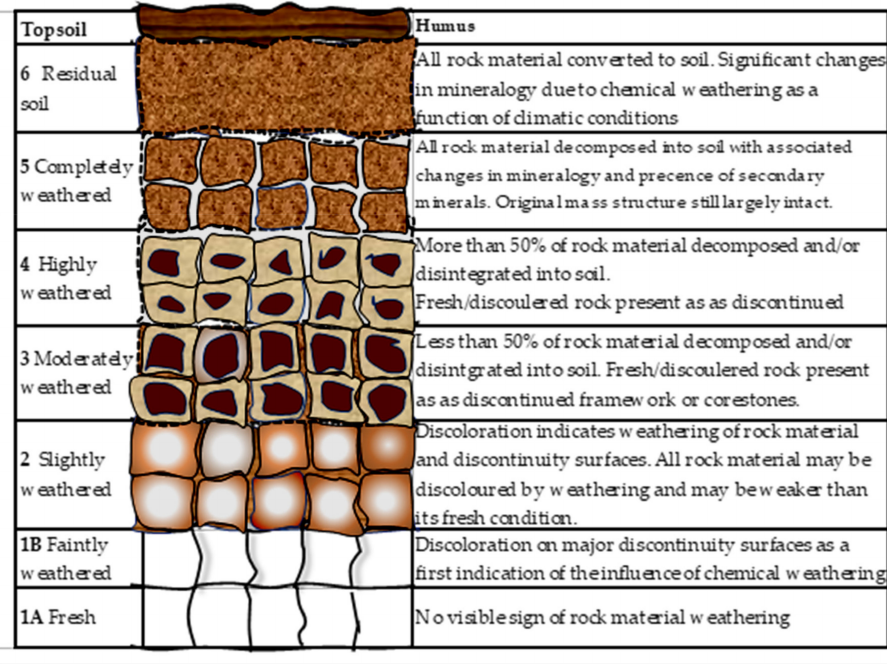
Figure 8. Schematic illustration of tropical weathering profiles (based on